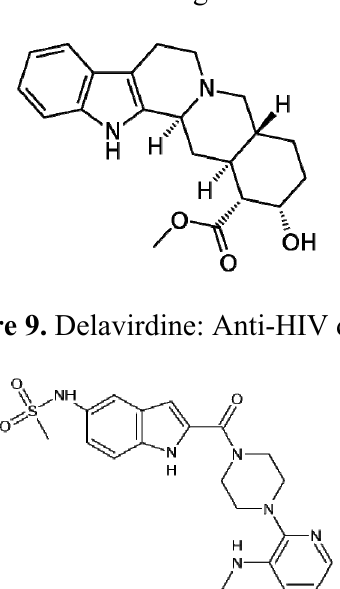
Figure 8. Yohimbine: Drug for male impotency.